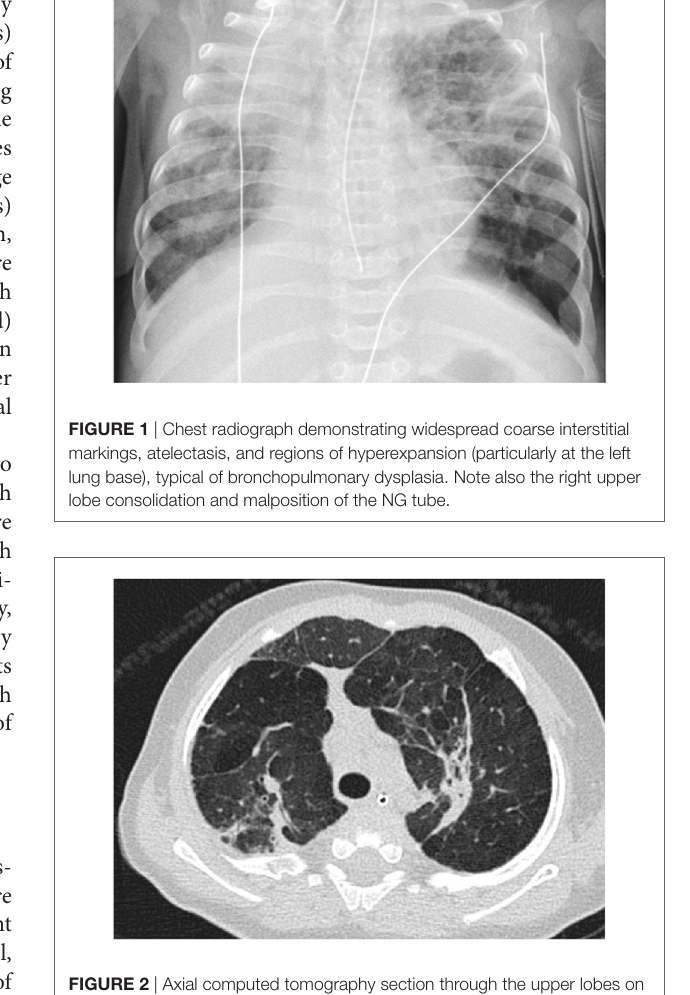
FigURe 2 | Axial computed tomography section through the upper lobes on lung window settings demonstrates linear and subpleural opacities, bronchial wall thickening, and areas of low attenuation (indicative of small airways disease) in a patient with bronchopulmonary dysplasia.